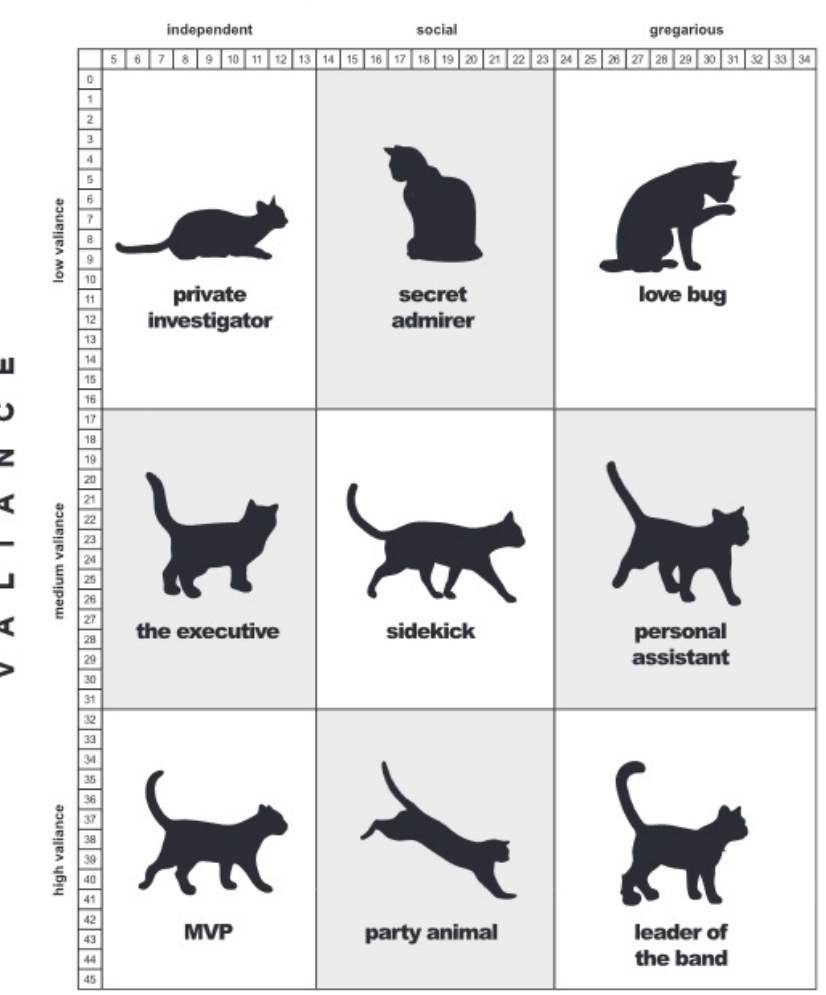
Figure 2. ASPCA (cid:114) Meet Your Match (cid:114) Feline-ality™ program personality scale from the Figure 2. ASPCA ® Meet Your Match ® Feline-ality™ program personality scale from the Original Assessment Original Assessment Group.